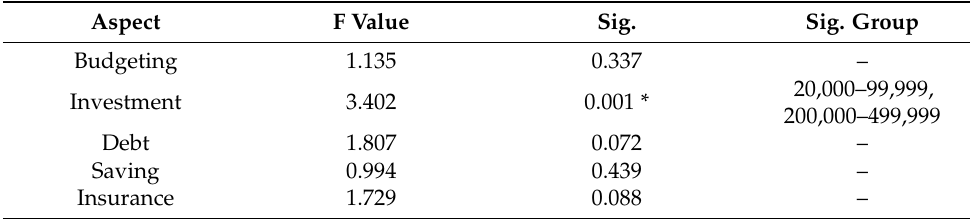
Table 13. Differences according to annual income using the ANOVA test ( n = 887). Aspect